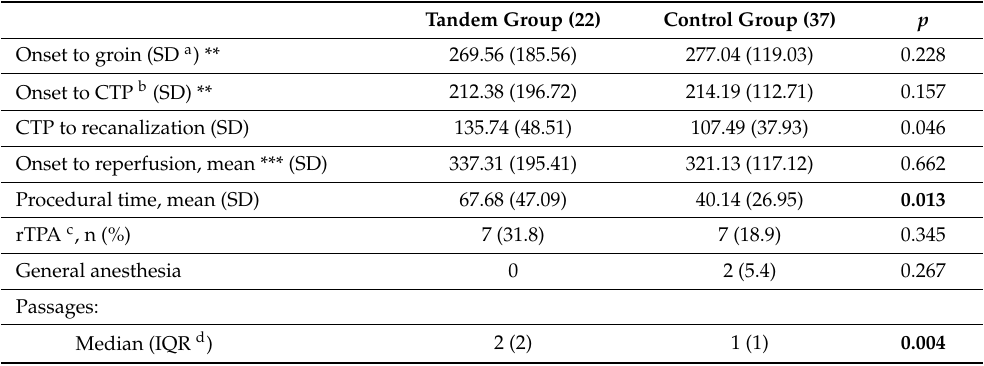
Table 2. Comparisons between groups for interventional and outcome